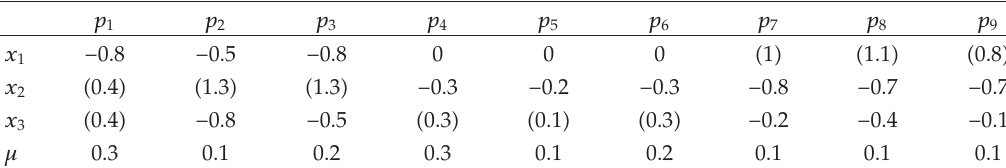
Table 2: Numerical grade r p ∈ P (cid:4) x i (cid:5) .